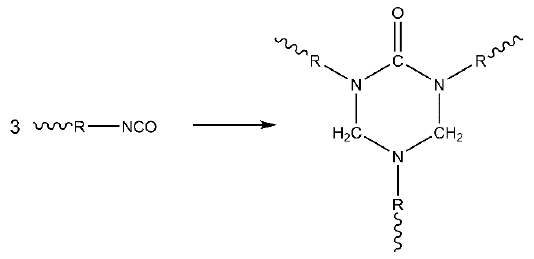
Figure 4. Trimerization of isocyanates.